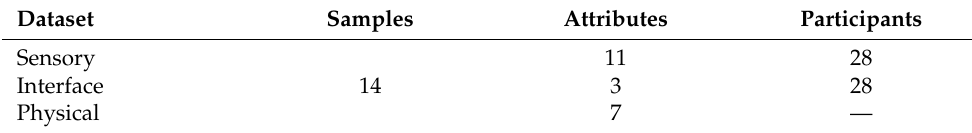
Table 3. Structure of the